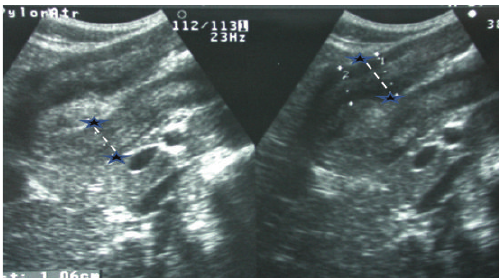
Figure 1: Fullness at epigastrium due to gastric distension.